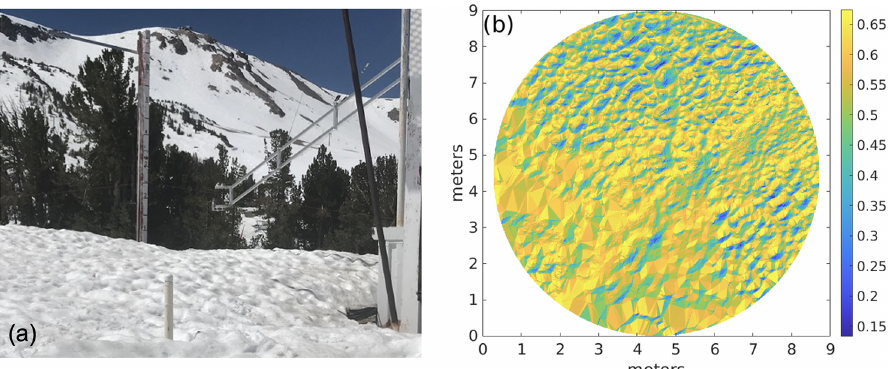
Figure 5. Snow with ablation hollows on 12 May 2021 at 10:45:00PST. (a) Corresponding apparent albedo seen by the radiometer. (b) The uncorrected albedo is 0.54 (mean of what is shown). The albedo with a planar correction is 0.55, and the intrinsic albedo based on the spatial analysis is 0.61.